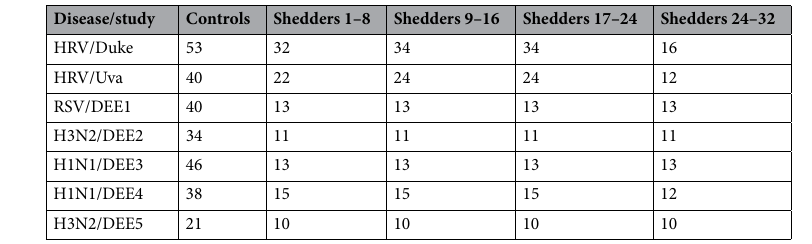
Table 1. Number of samples by study and time bin interval in hours over the first 32